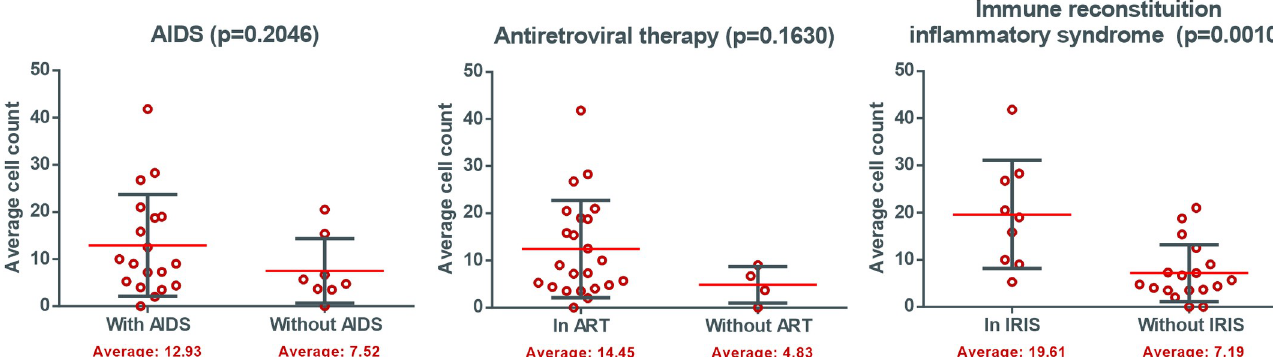
Fig 5. Density of cells expressing FOXP3 in leprosy patients with HIV co-infection according to the presence of AIDS, ART and IRIS. � Antiretroviral therapy (ART), Immune Reconstitution Syndrome (IRIS),